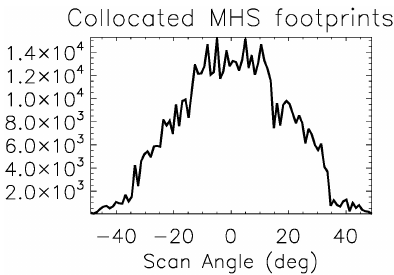
Figure 2. Total number of collocated and coincident MHS foot- prints as a function of scan angle between June 2006 and March